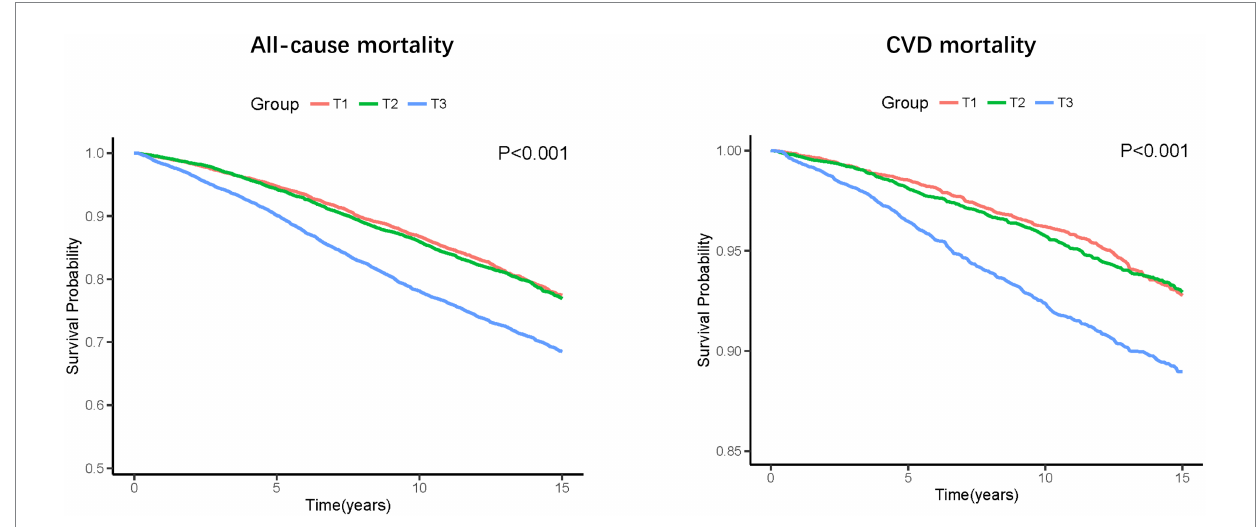
FIGURE 3 The all-cause and CVD mortality in different groups